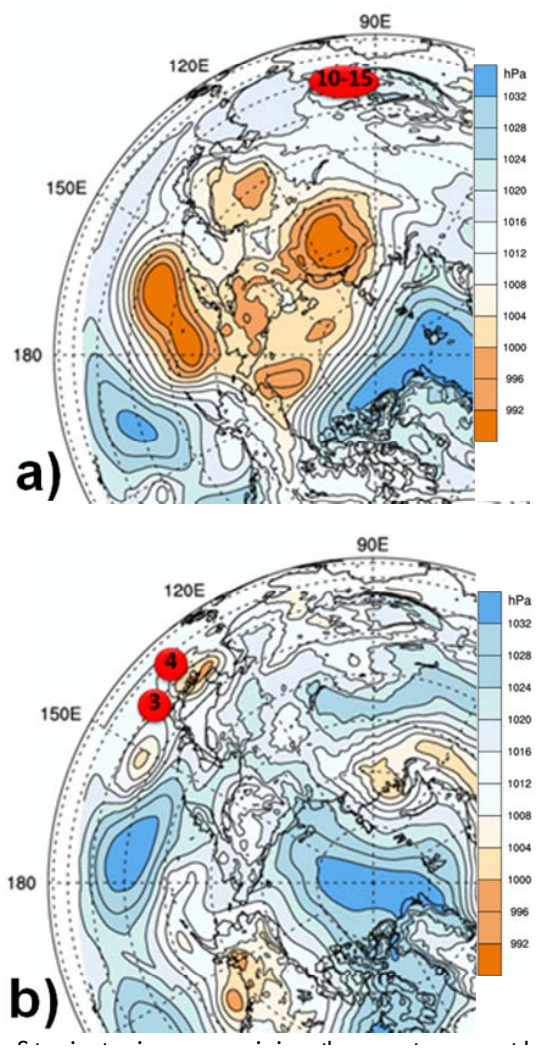
Fig. 8. Average location of trajectories comprising the westernmost branch in Fig. 6a (red circles) for (a) 10-15 days back from the flight, and (b) 3-4 days back.